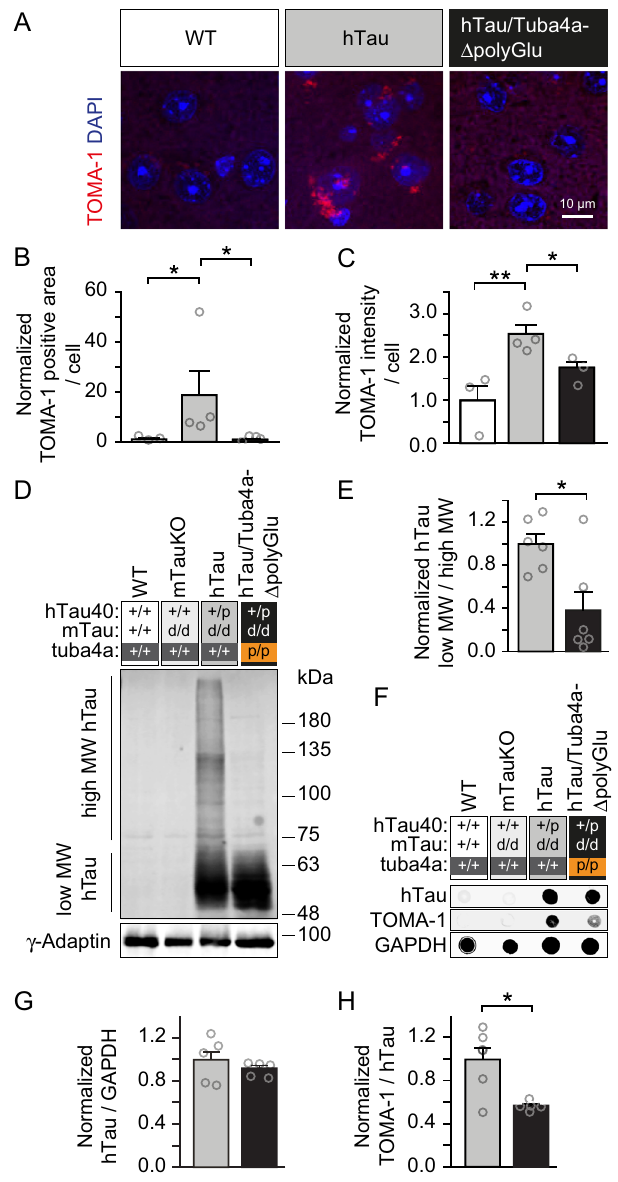
Loss of Tuba4a C-terminal polyglutamylation normalizes microglia activation in a tauopathy model . Microglia activation contributes to gliosis in response to neuronal damage and is a common pathological feature in tauopathies and AD 54 , accom- panied by the aggregation of hyper-phosphorylated Tau 7 . As expected, the hTau tauopathy model displayed strong levels of CD68 (Fig. 9A, B, gray header), a marker for activated microglia and actively phagocytic cells 55 . In contrast, hTau/Tuba4a Δ po- lyGlu mice, lacking Tuba4a polyglutamylation (black header), displayed signi fi cantly less CD68 expression, similar to wild-type controls (white header) (Fig. 9A, B). Coimmunostaining of CD68 with Iba1, a marker highlighting microglia morphology 56 , revealed that activated microglial cells had formed long branching processes in the tauopathy model that were marginally developed in hTau/Tuba4a Δ polyGlu mice (Fig. 9C, green processes). The